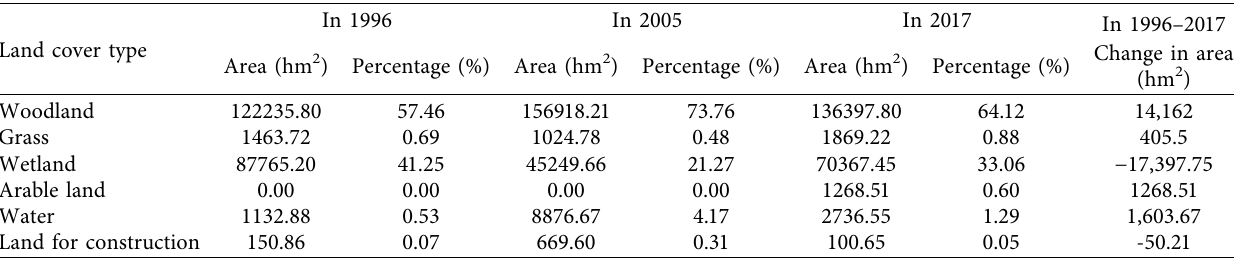
Table 6: Change table of the land cover type area.